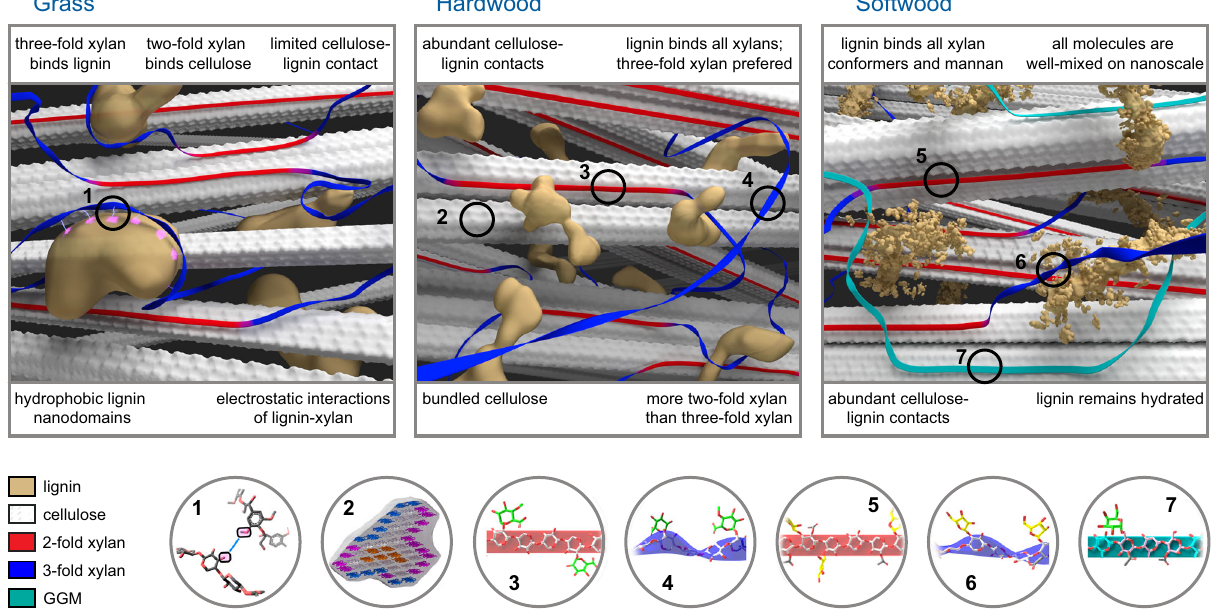
Fig. 6 Comparative schemes of secondary cell walls in grass, hardwood, and softwood. The fi gure shows the spatial arrangement of lignin (yellow), cellulose (white fi brils), two-fold xylan (red fl at ribbons), three-fold xylan (blue twisted ribbons), mixed forms of xylan (magenta), and mannan (GGM; green) in secondary plant cell walls. Numbered spheres highlight the structural features of (1) lignin – xylan interaction in all plants, (2) cellulose bundles in woody plants, (3 – 6) two-fold and three-fold xylan with different sidechains, and (7) galactoglucomannan. The molecular fraction of polysaccharides is considered in the depiction, but the illustration may not be strictly to scale. The model of grass cell wall is generated using the data recently reported 24 , for comparison with the models of woody plants. Lignin and carbohydrates are much better mixed in woody plants than in grass, resulting in the binding of lignin to both three-fold and two-fold xylan as well as to cellulose micro fi brils. The structural assembly of woody cell walls is thus different from the domain-separation scheme of grass cell